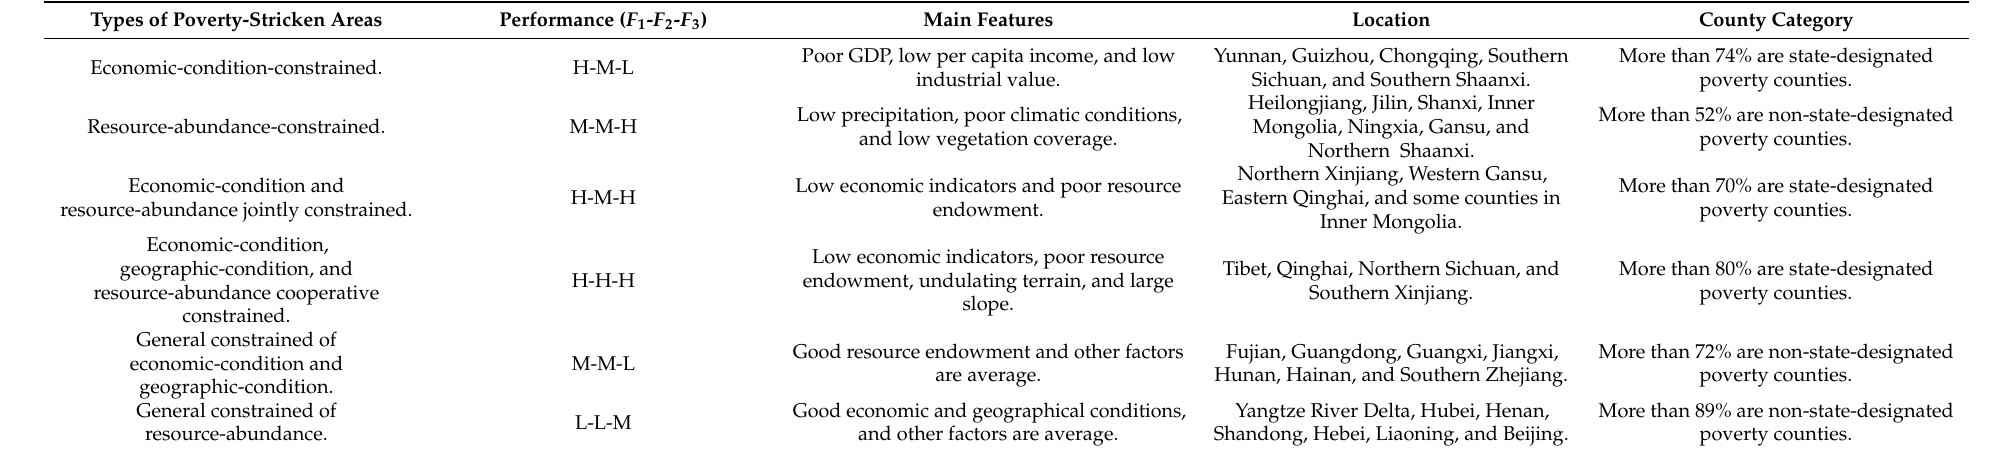
Table 8. Characteristics and distribution of different types of impoverished